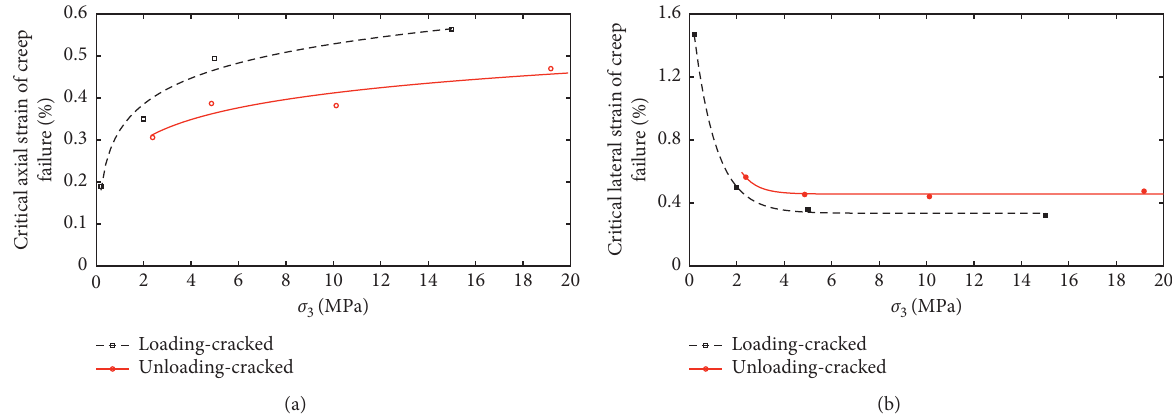
Figure 4: Variation of critical strain of creep failure with confining pressure. (a) Axial strain. (b) Unloading-cracked samples.